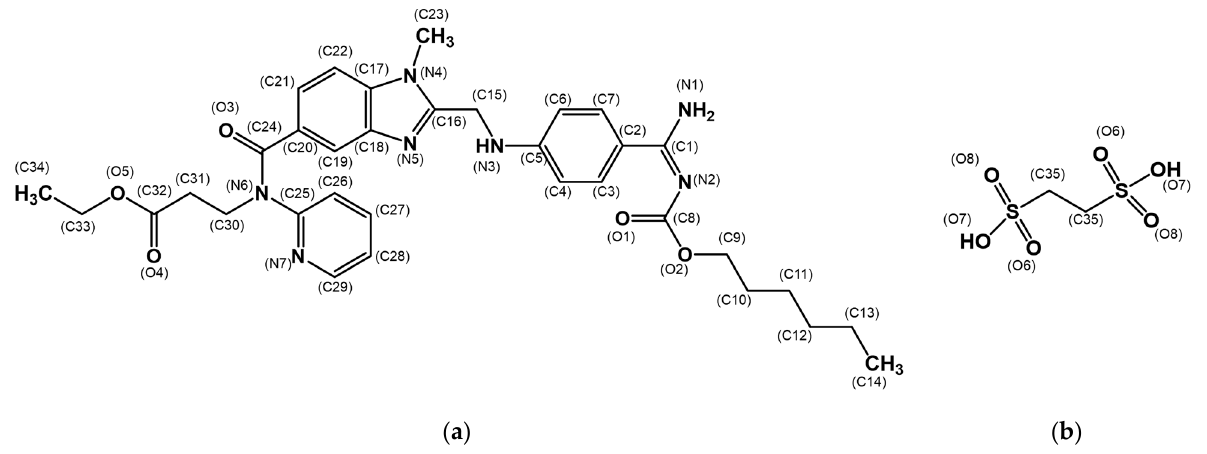
Figure 1. Molecular structure with atom numbers: ( a ) Dabigatran Etexilate (DBG), ( b ) Edisilic acid.